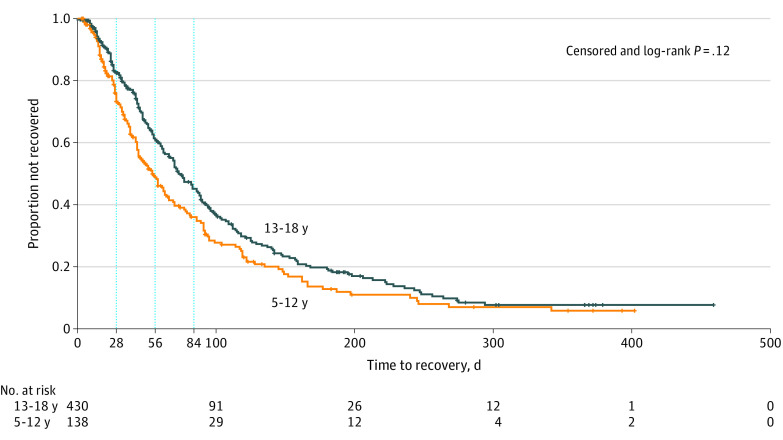
Kaplan-Meier Curves for Time to Recovery by Age Category